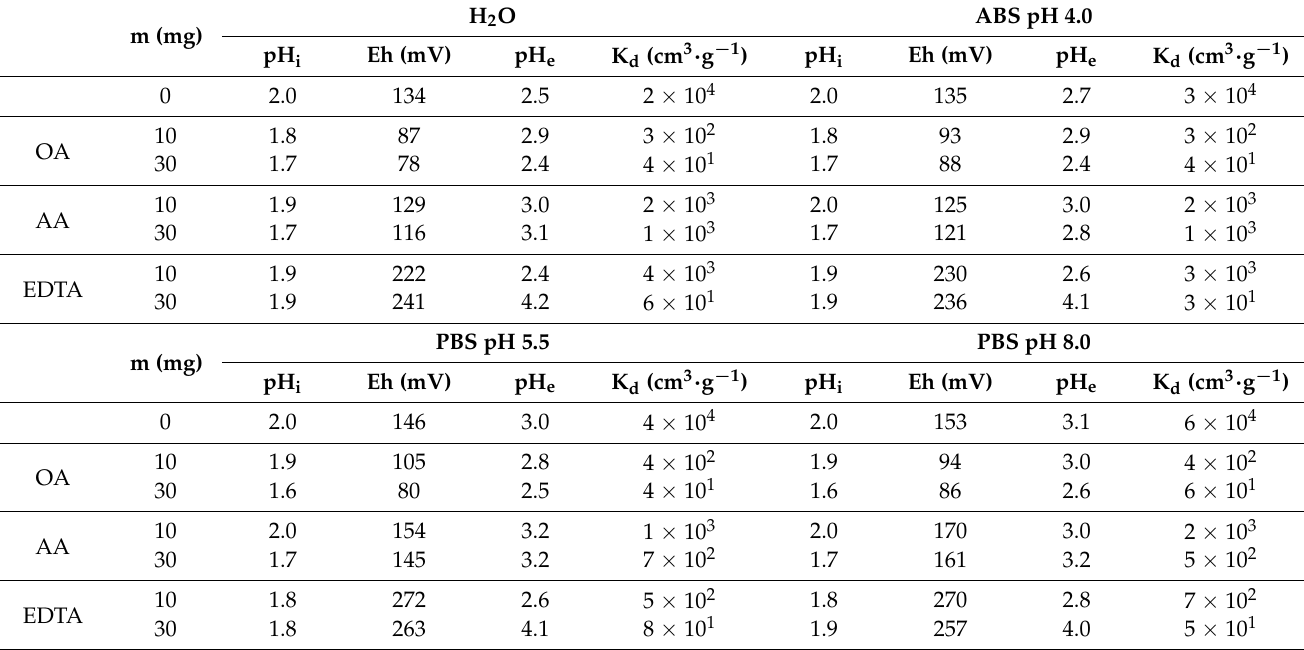
Table 1. Parameters of technetium sorption on hydroxyapatite in a reducing environment in the presence of SnCl 2